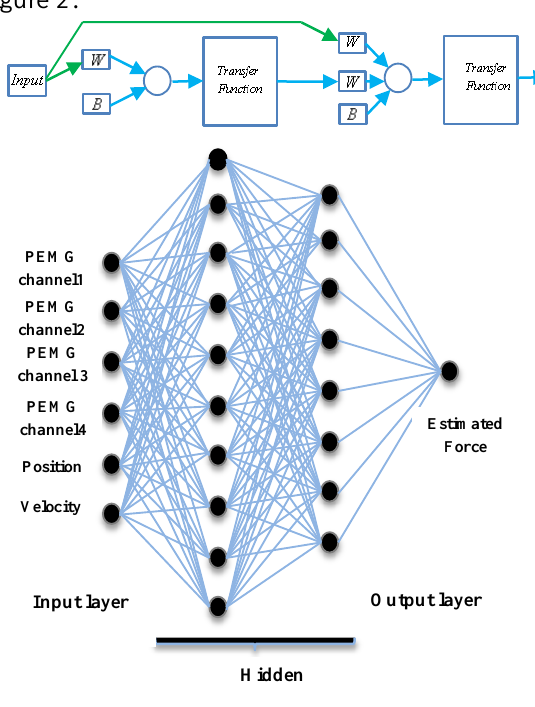
Figure 2. Cascade (up) and MLP (down) neural network